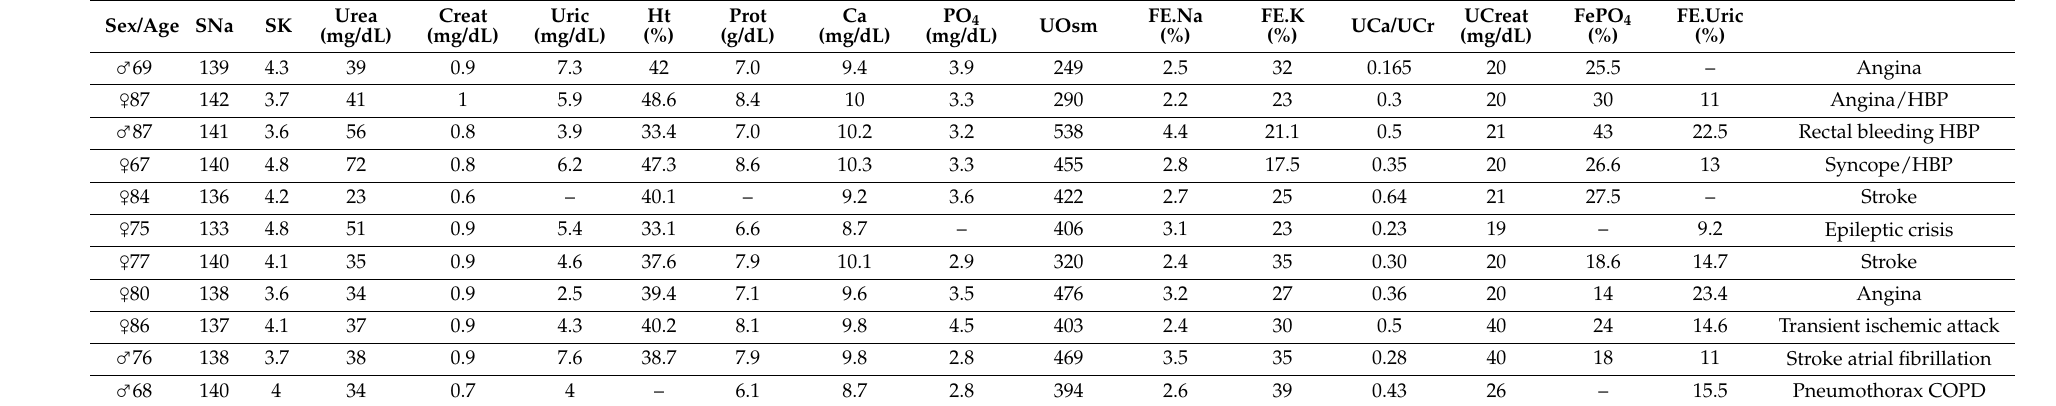
Table 1. Patients with TRSW (transient renal salt